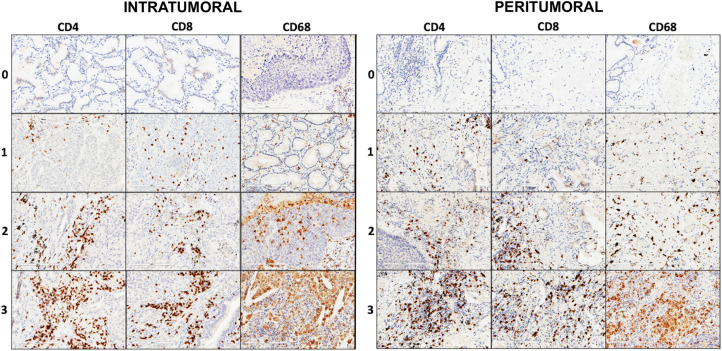
Explicative pictures of the scores (0, 1, 2, 3) for each immunohistochemistry (IHC) marker (CD4, CD8, and CD68), respectively, in IT and PT areas (IHC, original magnification × 200).